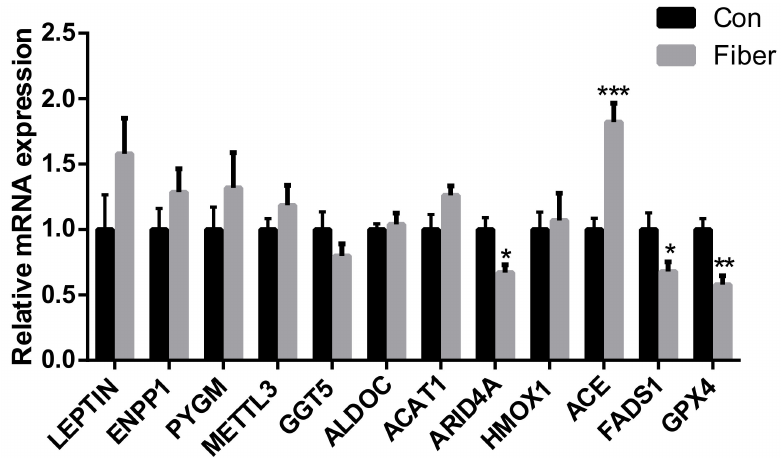
Figure 7. E ff ect of maternal fiber intake on the relative expression of mRNA. The values were expressed as mean ± SEM. * means p < 0.05, ** p < 0.01, *** p < 0.001, as compared to normal control group. Con = control group, Fiber = Fiber